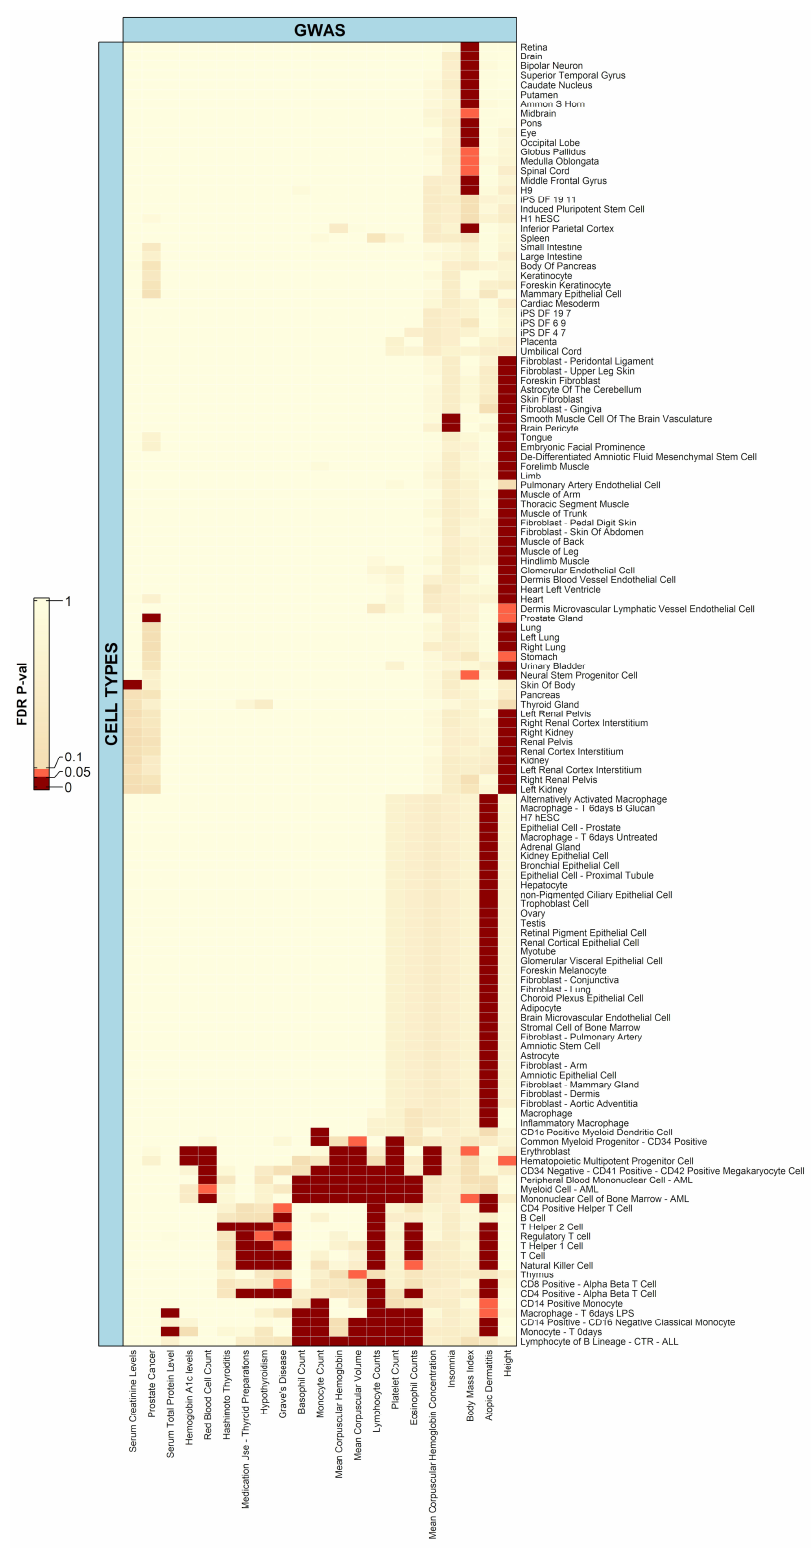
Figure 1. Heatmap depicting associations of 137 cell types form bulk chromatin accessibility data (from OCHROdb database) with 21 phenotypes. Of 201 phenotypes, 21 had a significant association (FDR adjusted p -value ≤ 0.05) with at least one cell type. In the heatmaps, dark red boxes represent significant association with an FDR adjusted p -value less than or equal to 0.05, while light red boxes represent trend association with an FDR adjusted p -value less than or equal to 0.10 but greater than